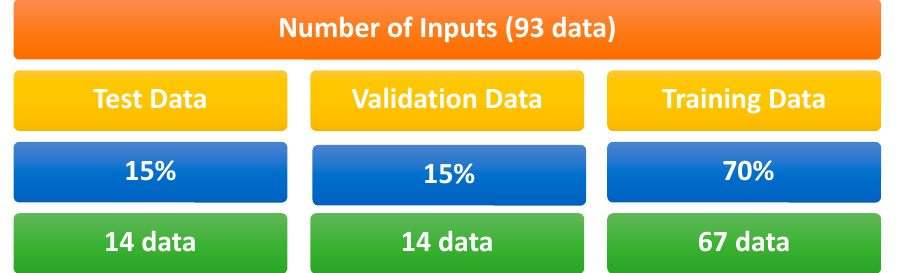
Figure 2. Randomized classification of empirical data in order to construct a neural network model.